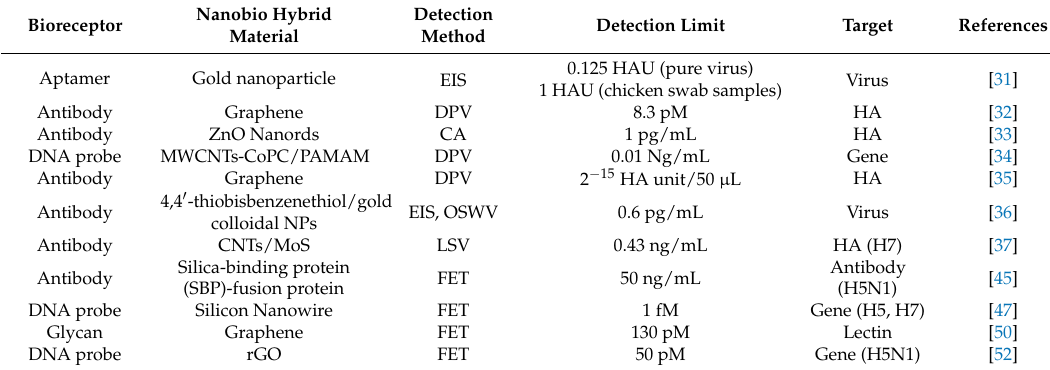
Table 1. Comparison of the electrochemical (EC)-based biosensor and field-effect transistor (FET)-based for avian influenza virus (AIV) detection in terms of receptor materials, nanobio hybrid material, detection method, detection limit and